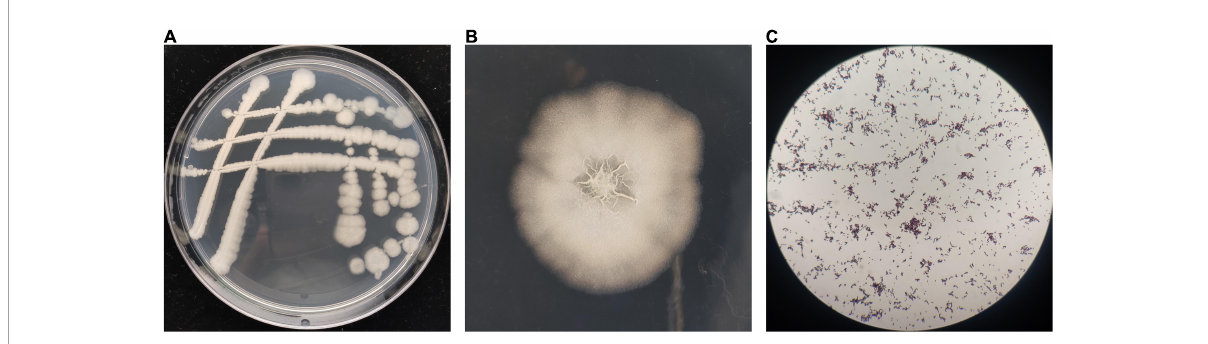
FIGURE3 Colony morphological characteristics of BR-01. (A) Appearance of antagonistic bacterium BR-01 on NA medium. (B) Antagonistic bacterium BR-01 single colony morphology. (C) Gram staining of antagonistic bacterium BR-01.